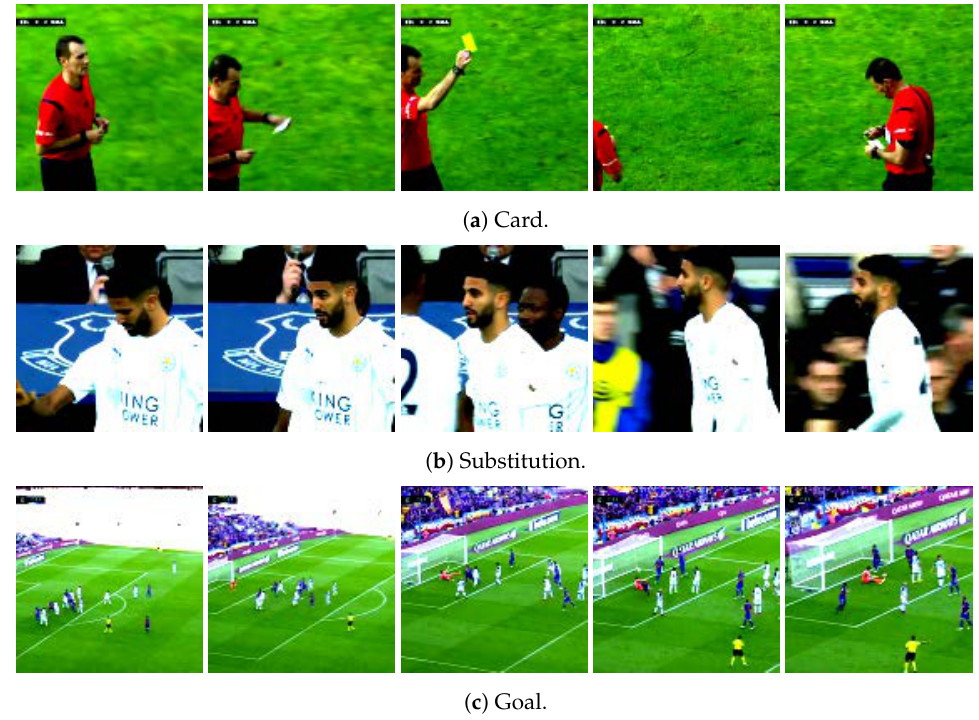
Figure 1. Sample frames from the SoccerNet dataset [1] for three different event types. The middle frame is at the annotated time for the